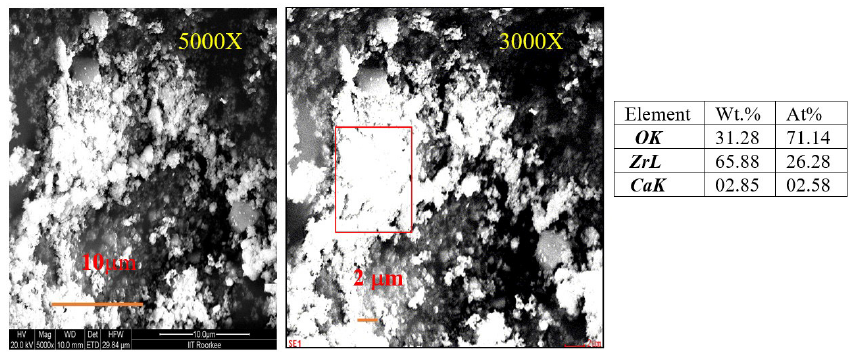
Figure 1. SEM and EDS analysis for 9 mol % CaO powder